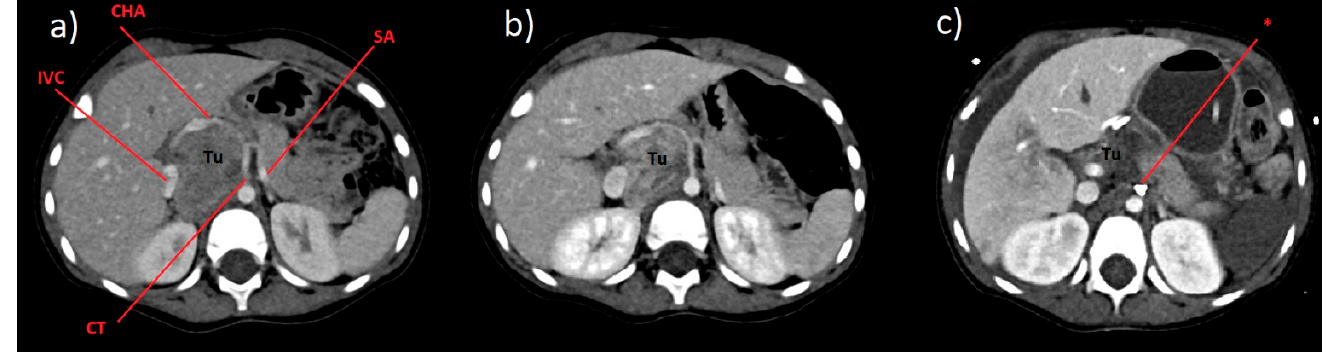
Figure 1. Axial abdominal computed tomography scans in venous phase showed a retroperitoneal tumor in three different examinations of our patient—( a ) pre-treatment; ( b ) after two courses of chemotherapy; ( c ) postoperative. * in postoperative examination, there was no contrast enhancement of the celiac trunk. In its typical location, the vascular clips were found.